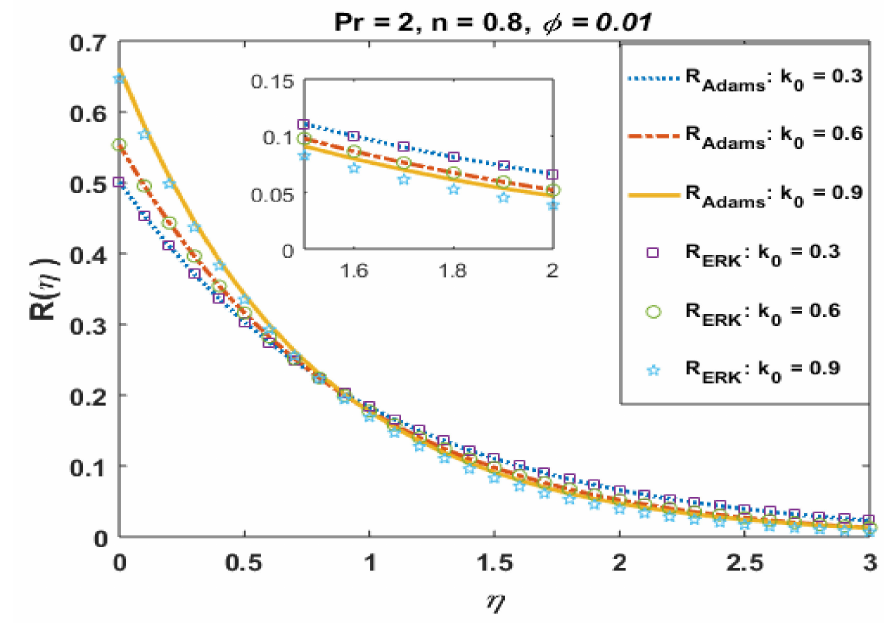
Figure 3. Effects of k 0 on R ( η ) .